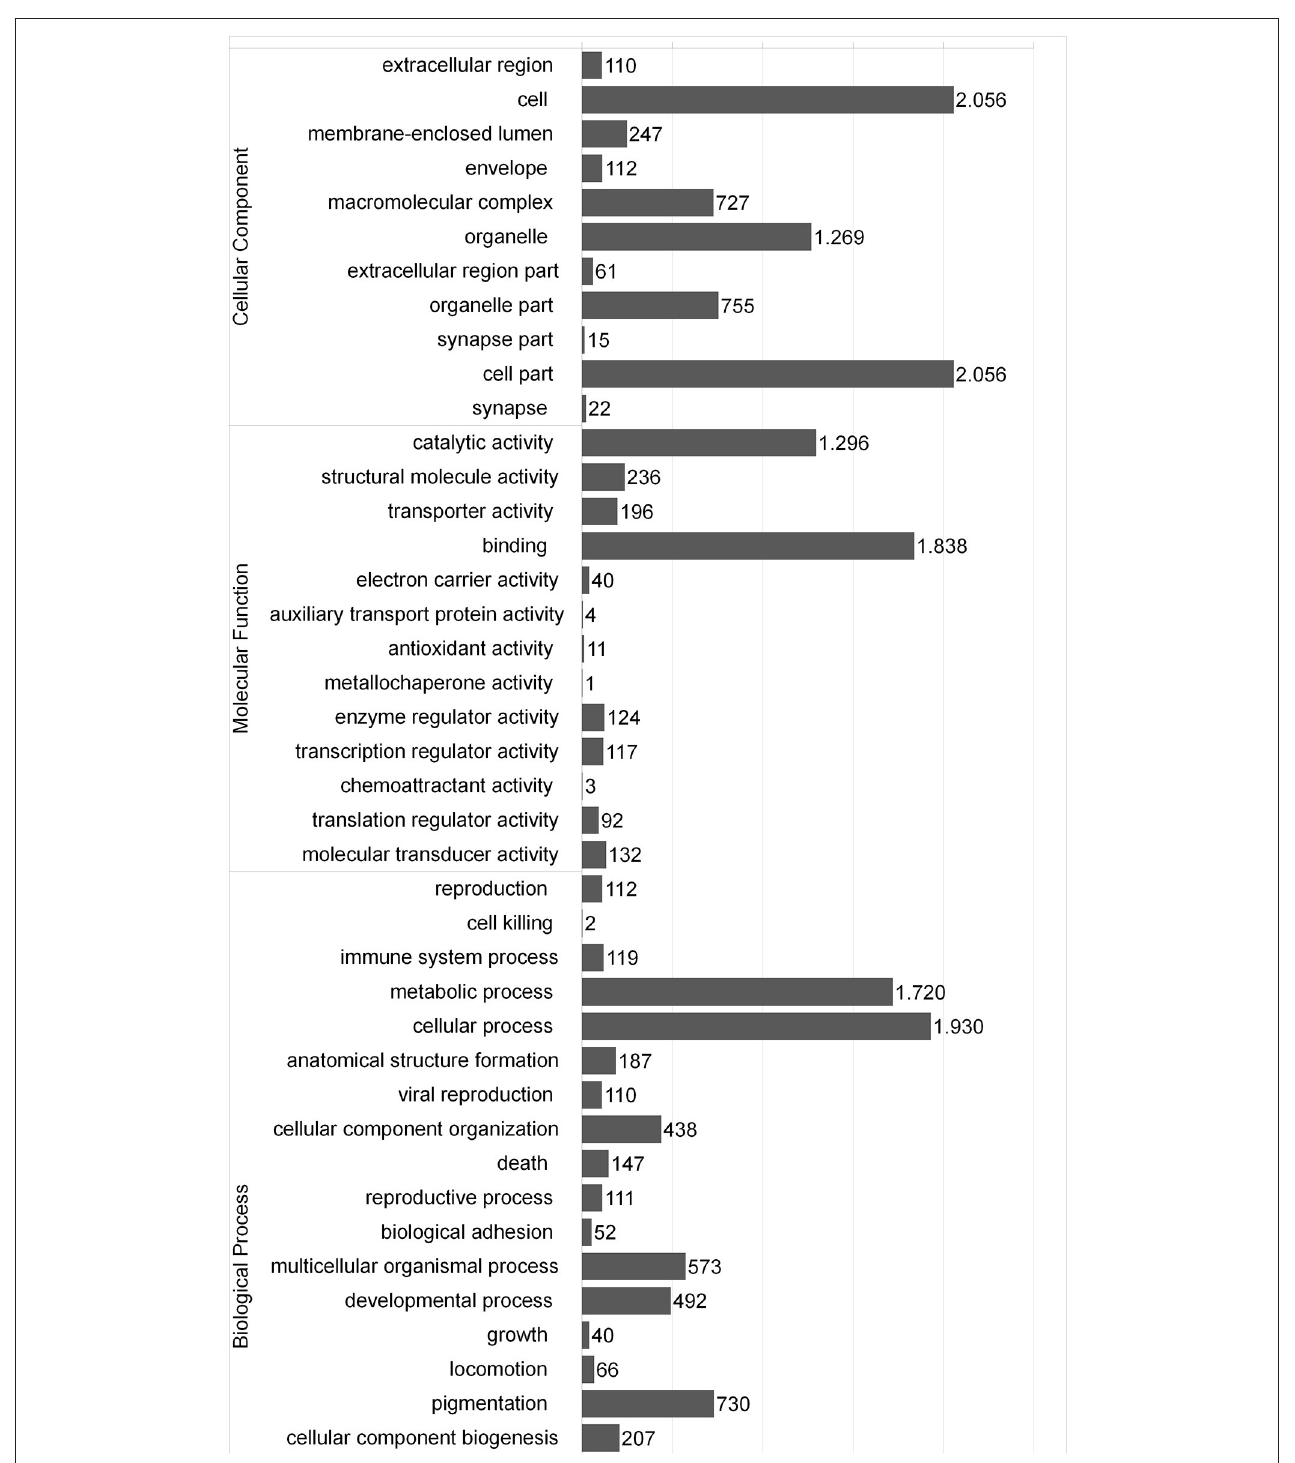
FIGURE 1 | Gene ontology classification (level